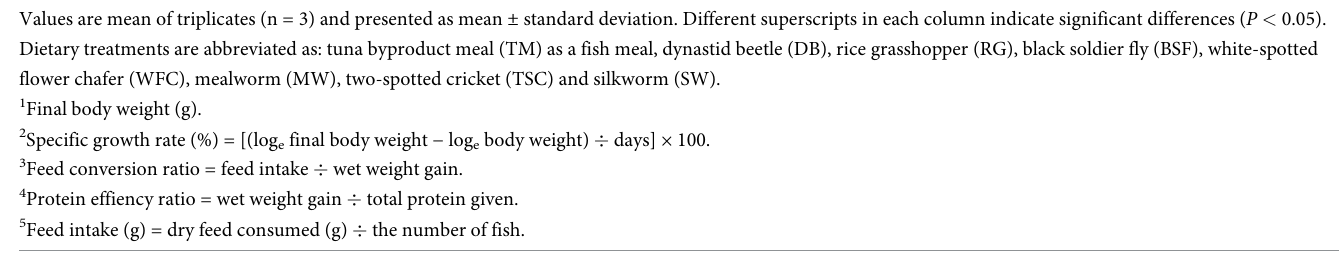
Values are mean of triplicates (n = 3) and presented as mean ± standard deviation. Different superscripts in each column indicate significant differences ( P < 0.05). Dietary treatments are abbreviated as: tuna byproduct meal (TM) as a fish meal, dynastid beetle (DB), rice grasshopper (RG), black soldier fly (BSF), white-spotted flower chafer (WFC), mealworm (MW), two-spotted cricket (TSC) and silkworm (SW). 1 Final body weight (g).